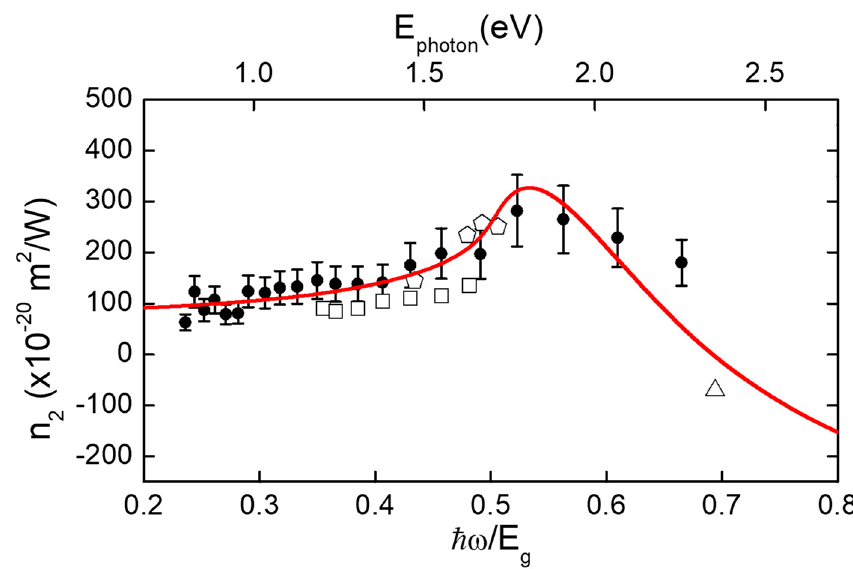
Figure 3. Experimental (solid circles) and theoretical (line) dispersion of the nonlinear refractive index (n 2 ) of GaN with respect to its band gap energy of 3.39 eV. Literature data are plotted as pentagons [39], up-triangles [41], and hollow squares [43].